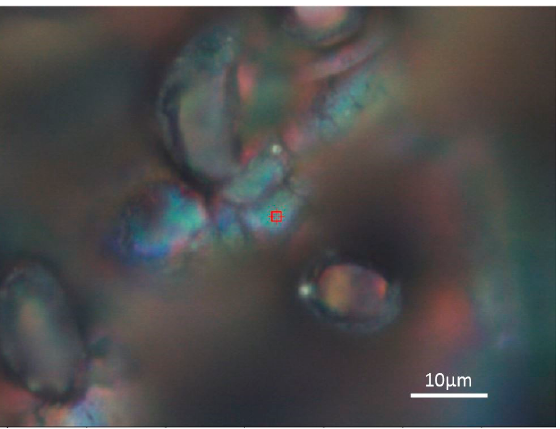
Figure 10. Detailed optical image of the blue-green area of the laser patterned sample.